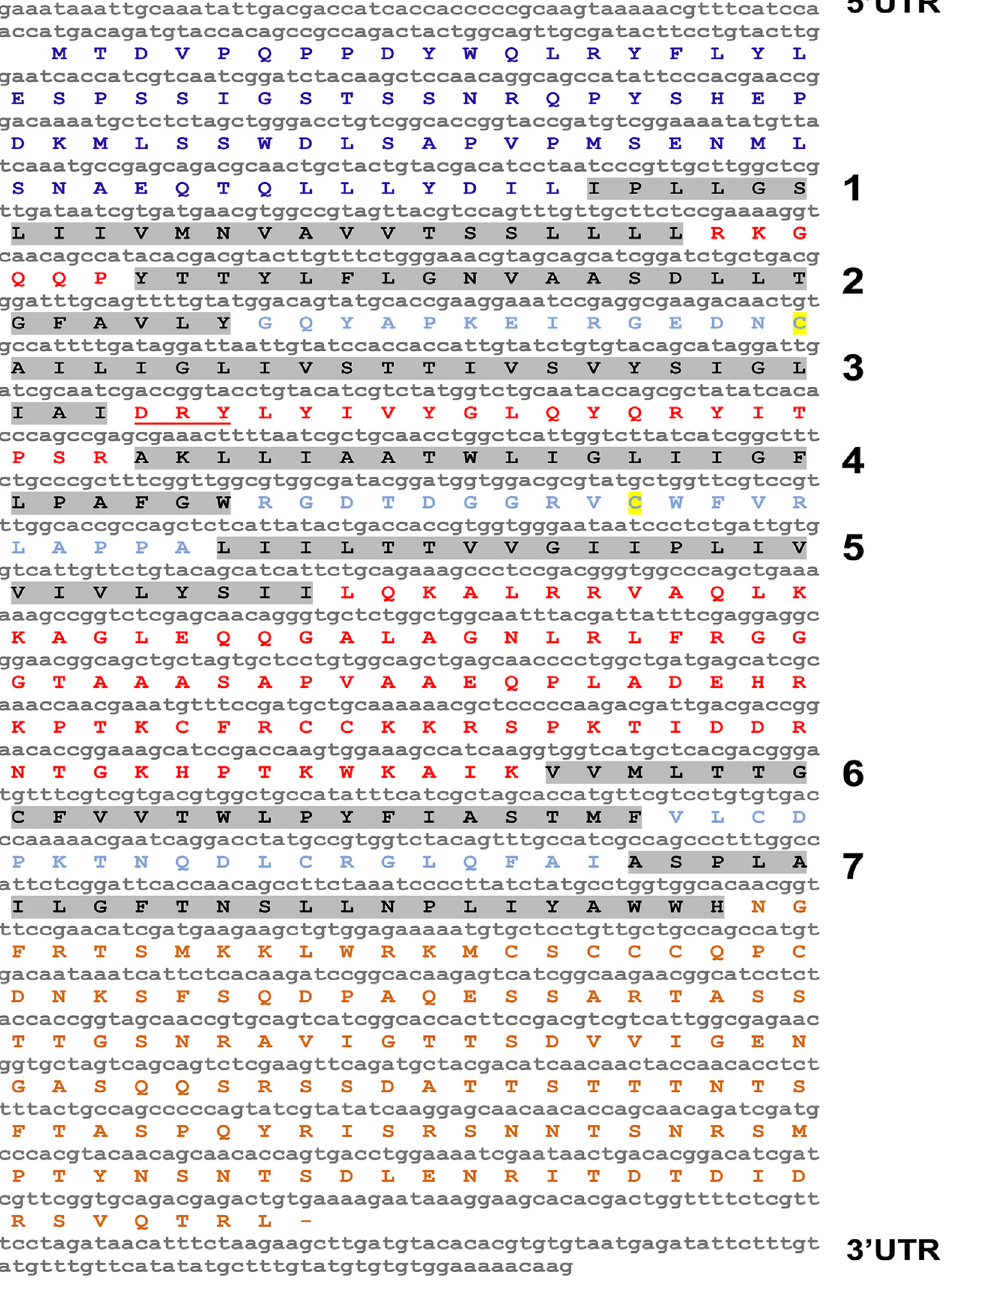
Fig 1. Complete AaSeR-1 cDNA sequence with predicted ORF and 5 ’ and 3 ’ UTR. Prediction analyses identified features typical of GPCRs — seven TM domains (in grey), extracellular N- terminal (in dark blue), cytoplasmic C-terminal (in brown) and six loops (3 extracellular — in pale blue; 3 cytoplasmic — in red). The ‘ DRY ’ motif (underlined in red) which is highly conserved among GPCRs is positioned in the second cytoplasmic